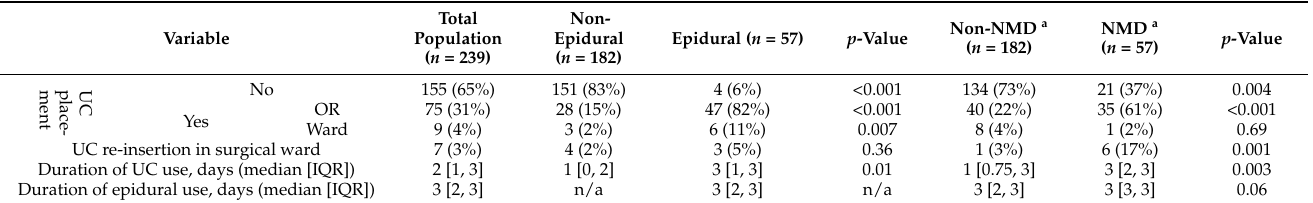
Table 2. Urinary catheter management of children undergoing orthopedic surgery of the hips or lower extremities with and without epidural